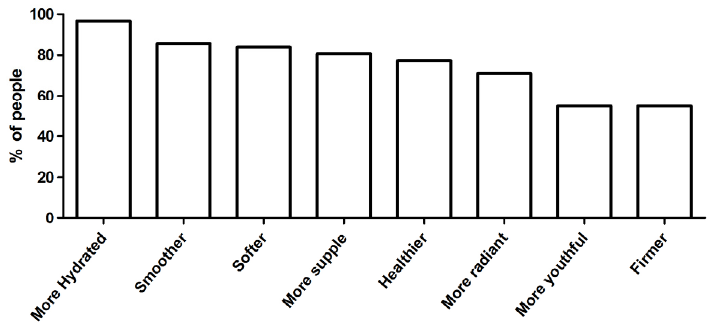
Figure 3. Self-Perception Questionnaire responses of the pilot study subjects after one application of the test product.